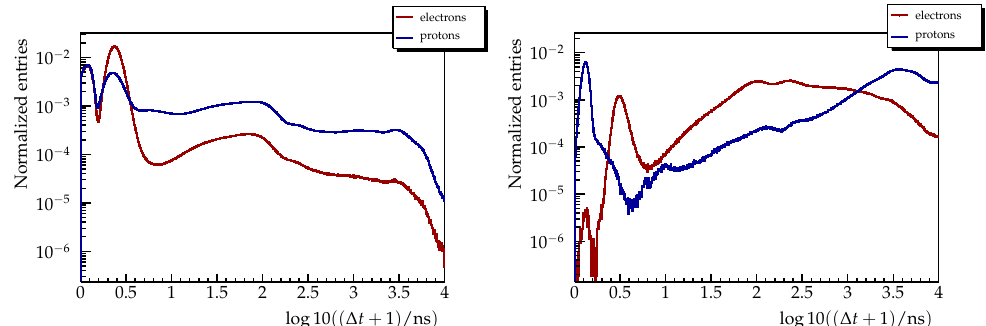
Figure 4. Inclusive distributions of time measurements assuming a timing resolution of ∼ 100ps for 700GeV electrons (red) and 1TeV protons (blue), depositing 600GeV to 800GeV energy in the calorimeter. Each entry represents the timing information associated to one hit in the tracker. ( Left ): distribution for all tracker hits in the event. ( Right ): distribution for the latest hit in the event. We indicate, with “latest”, the hit in the event which has the highest delay with respect to the first primary particle hit. The distributions are obtained out of ∼ 5million generated